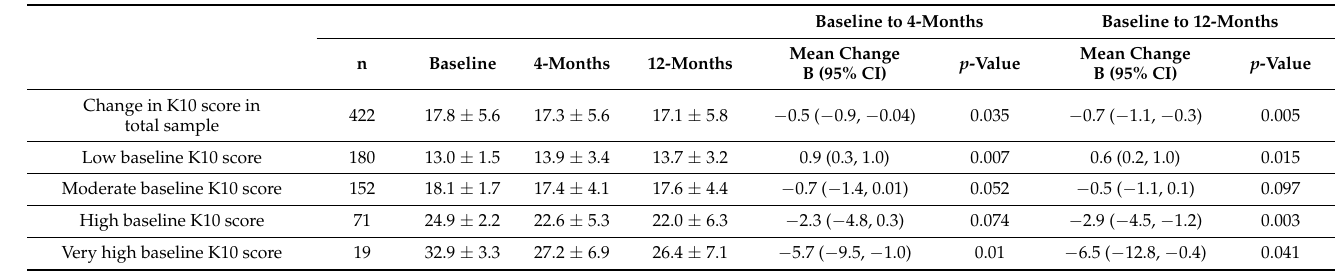
Table A3. Immediate and sustained change in psychological distress (K10 score) associated with participation in a physical activity workplace program (n =